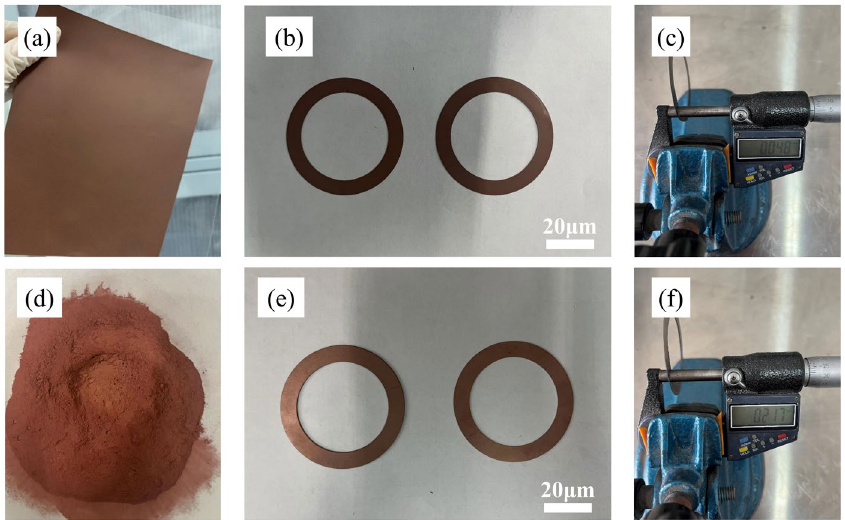
Figure 4. The picture of the precursors, green parts, and sintered parts manufactured by different methods: ( a – c ) Rolling-slitting; ( d – f ) Cold pressing.